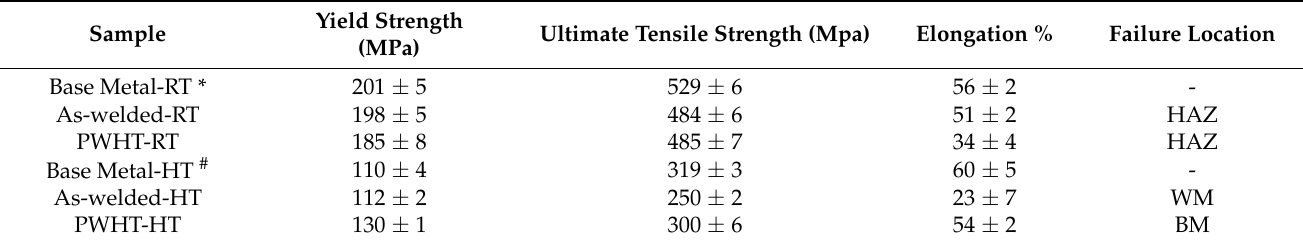
Table 3. The results of room-temperature and high temperature (700 °C) tensile testing of the alloy 800H base metal, as-welded, and PWHT weld joints (average properties from three tests in each case). Yield Strength Sample Ultimate Tensile Strength (Mpa) Elongation % Failure Location (MPa) Base Metal-RT * 201 ± 5 As-welded-RT 198 ± 5 PWHT-RT 185 ± 8 Base Metal-HT #